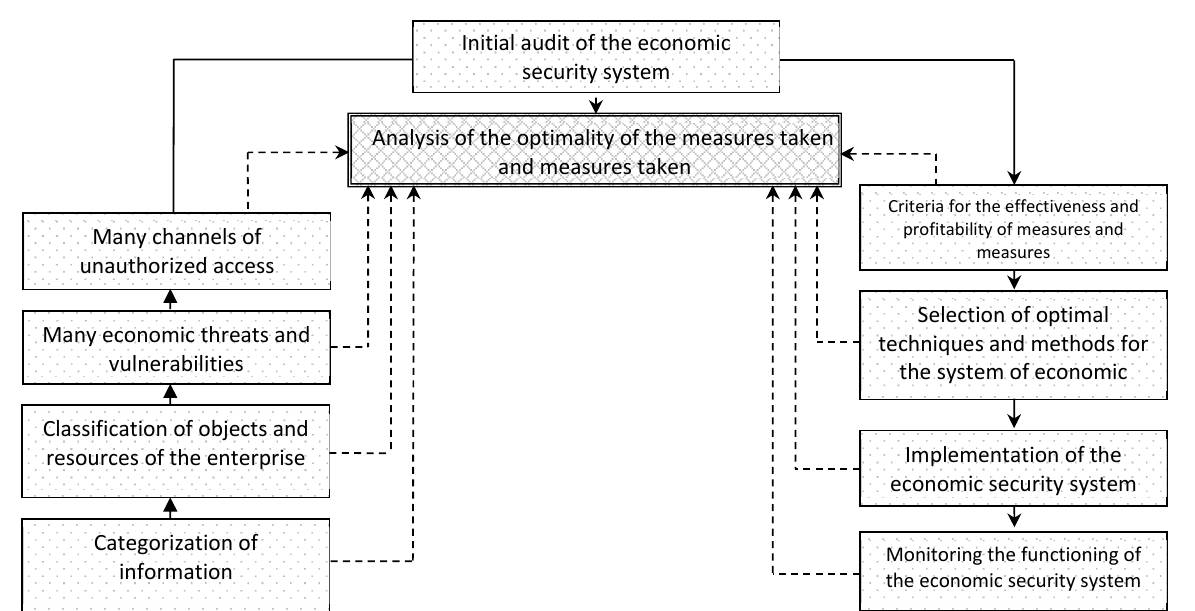
Fig. 4. Scheme of methods for building system enterprise economic